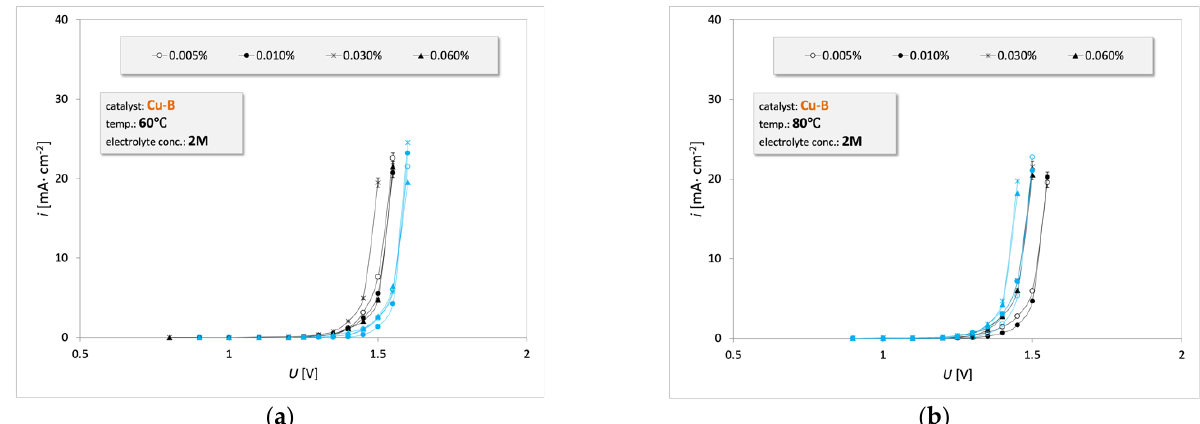
Figure 13. Electrooxidation curves of WEO emulsion (black lines) and detergent (blue lines) for various concentrations of detergent and emulsion on the Cu-B catalyst for an electrolyte concentration of 2 M. Electrooxidation: ( a ) temperature: 60 °C; ( b ) temperature: 80 °C.